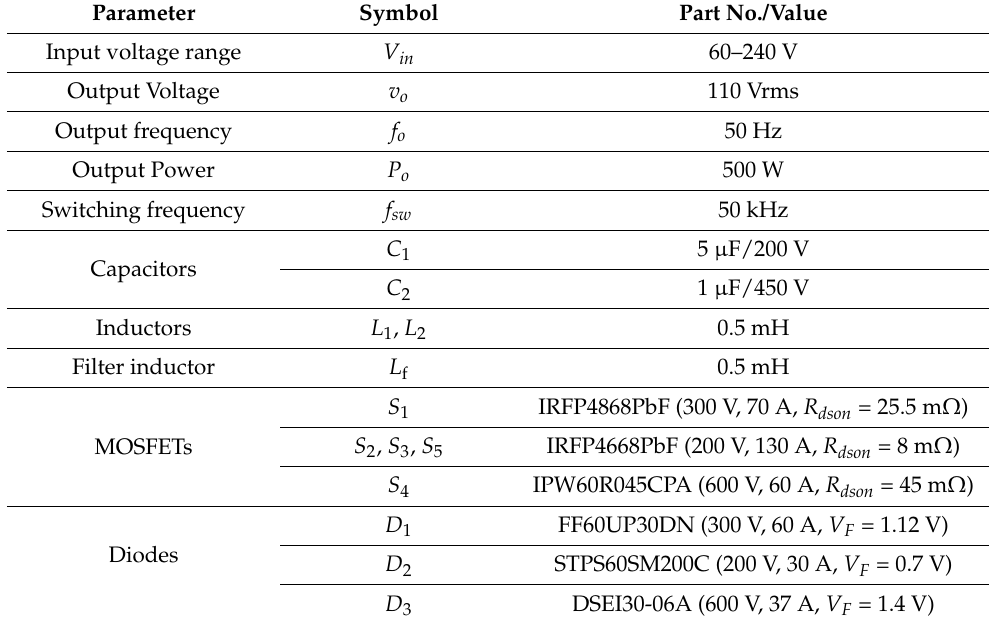
Table 2. Parameters of the proposed CGBBI topology.